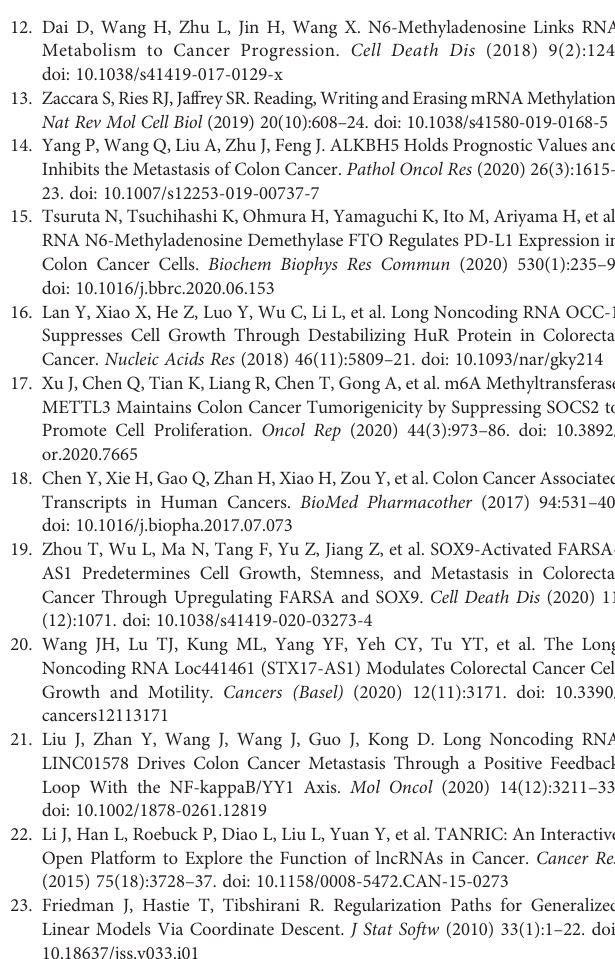
Supplementary Figure 1 | Validation of the m6A-TME-LM. (A) Kaplan – Meier curves showed that the high-risk subgroup had worse overall survival than the low- risk subgroup in test data set (TCGA). Receiver operating characteristic (ROC) curves of m6A-TME-LM for predicting the overall survival in TCGA data set. (B) Forest plot showed the result of univariate Cox regression